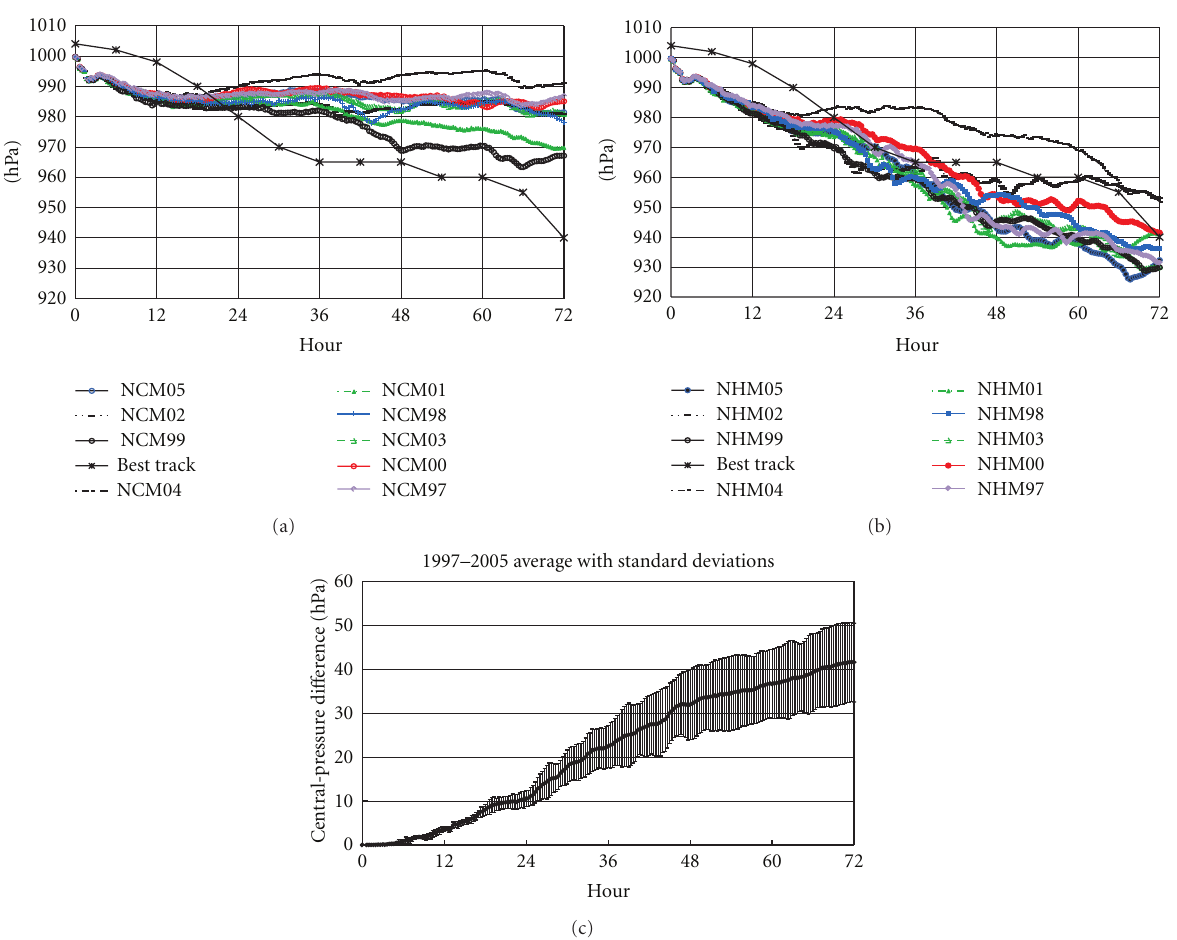
Figure 3: Time series of best-track central pressures (hPa) and central pressures predicted in each of the nine experiments by (a) NCM and (b) NHM. (c) Time series of the mean di ff erences in central pressure between NCM and NHM values averaged over the nine experiments and their standard deviations.